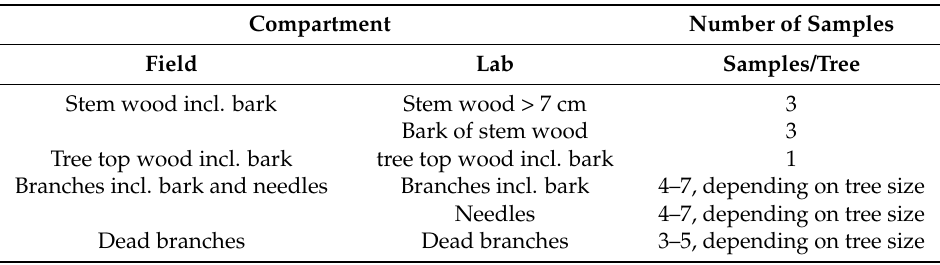
Table 2. Partitioning of the aboveground biomass into tree compartments in the field and in the lab, number of samples taken per tree and